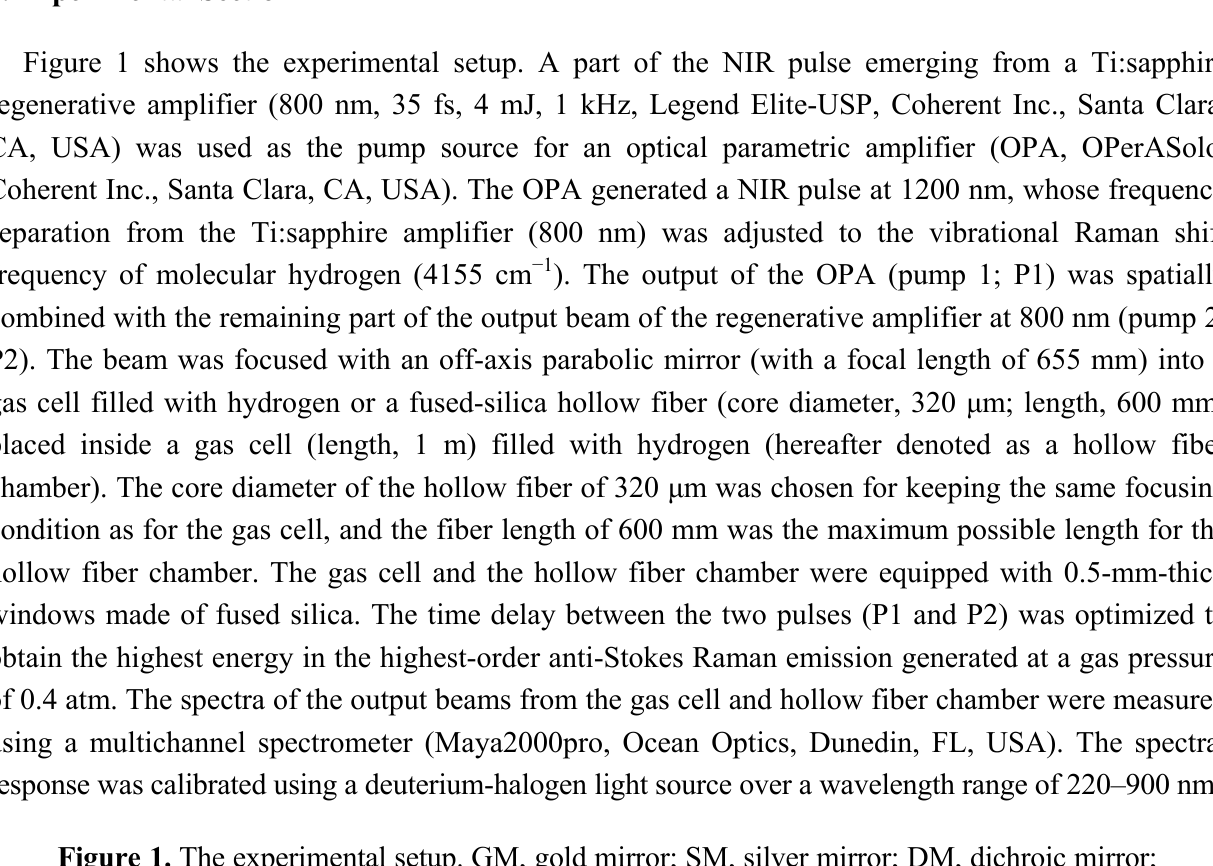
Figure 1. The experimental setup. GM, gold mirror; SM, silver mirror; DM, dichroic mirror; PM, off-axis parabolic mirror; BS, beam splitter; DMM, dielectric multi-layer mirror; VND, variable neutral density